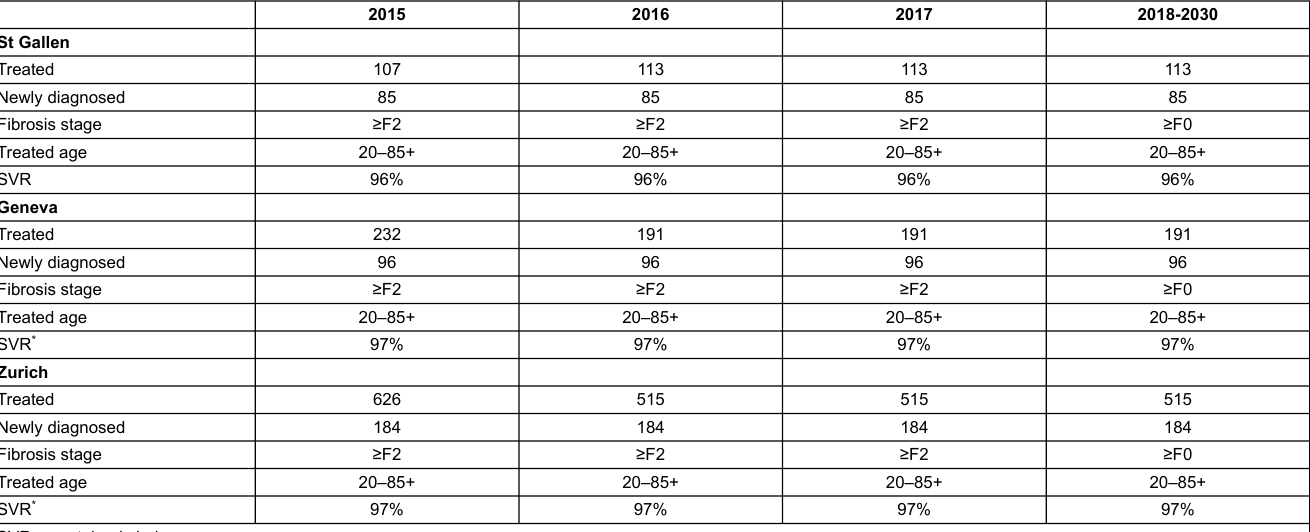
Table 3a: Inputs by scenario for St Gallen, Geneva, and Zurich 2015–2030: Base 2016.